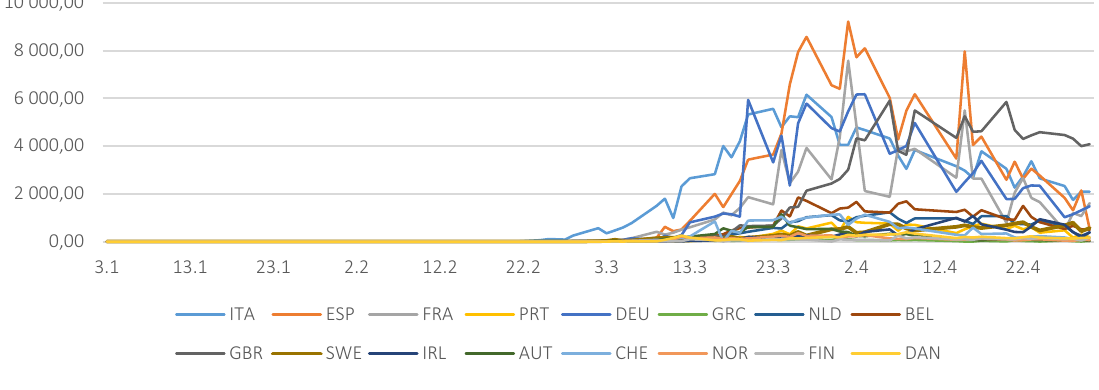
Figure 1. COVID-19 cases per European countries